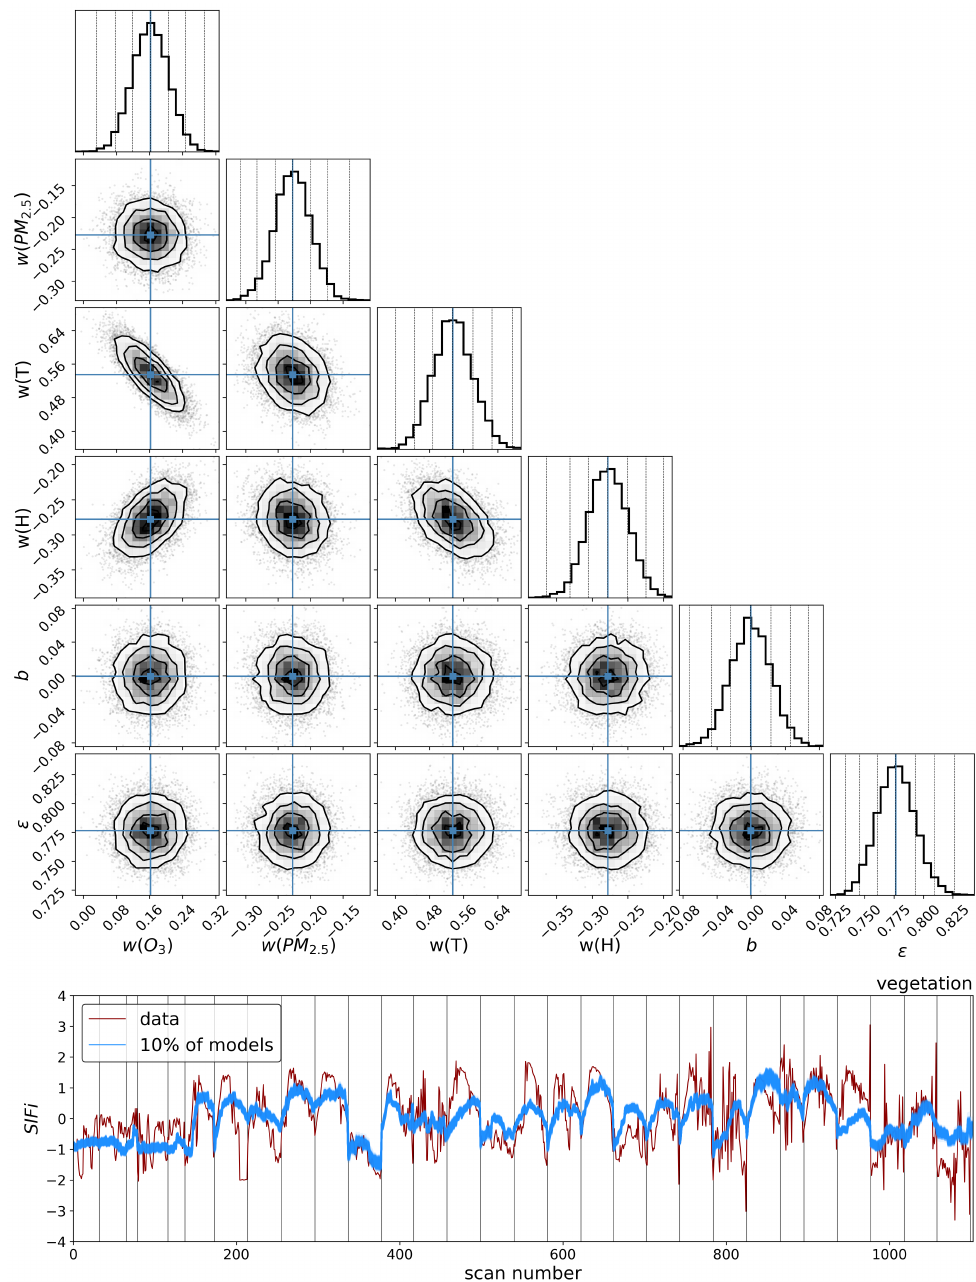
Figure 10. ( Top ): MCMC corner plot of the posterior distribution of air quality parameters for vegetation. ( Bottom ): The measured SIF indicator ( SIFi ) values as a function of scan number with 10% of randomly selected models from those identified as probable by MCMC, with the vertical lines indicating the change in